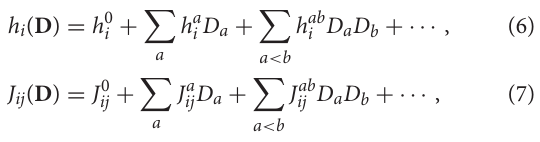
3 one-disease and M ab 2 = = a , ab is connected to k α signs =